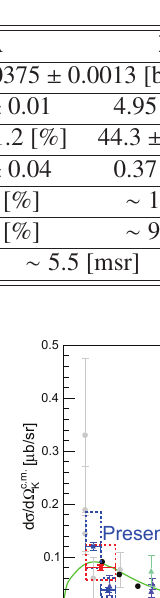
Table 1. Estimated quantities with statistical errors for deriving the di ff erential cross sections